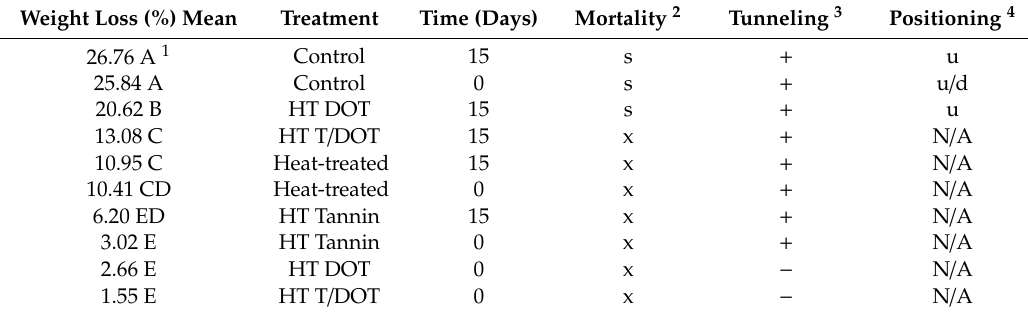
Table 3. Weight loss caused by Reticulitermes flavipes